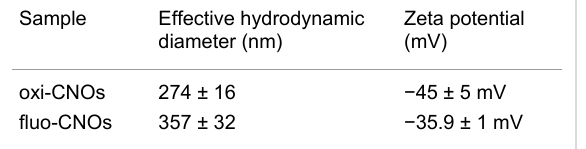
Confocal imaging